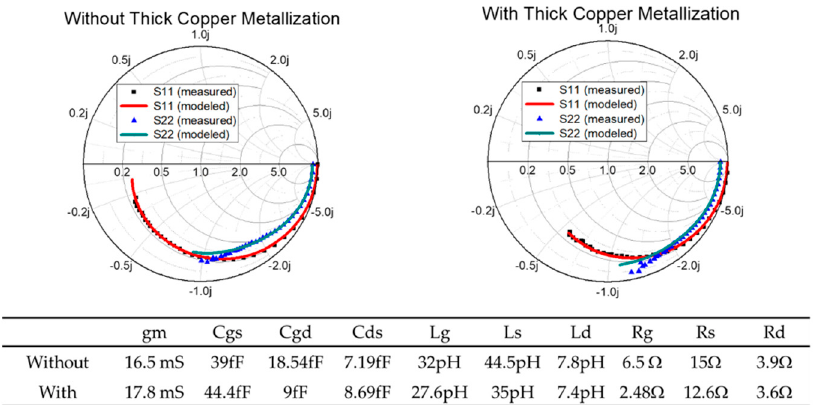
Figure 9. Measured and predicted S-parameters for the 2 × 20 µ m device with ( right ) and without ( left ) thick copper metallization. The small-signal circuit model was extracted using the procedure defined in [19].